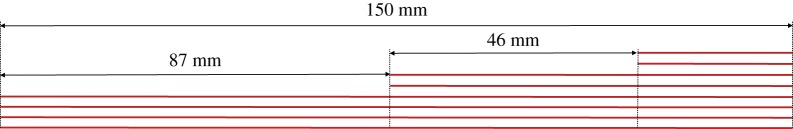
Composite lay-up for the monostable inlet with snap-through behaviour. Red lines represent composite layers. Step changes in thickness cause stiffness variations and the structural asymmetry required for monostable behaviour with snap through.